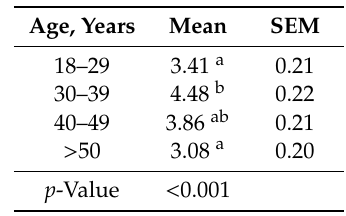
Table 2. Preference for animal products that originated from animals fed with insect meal depending on the age of respondents on a 1–7 scale.